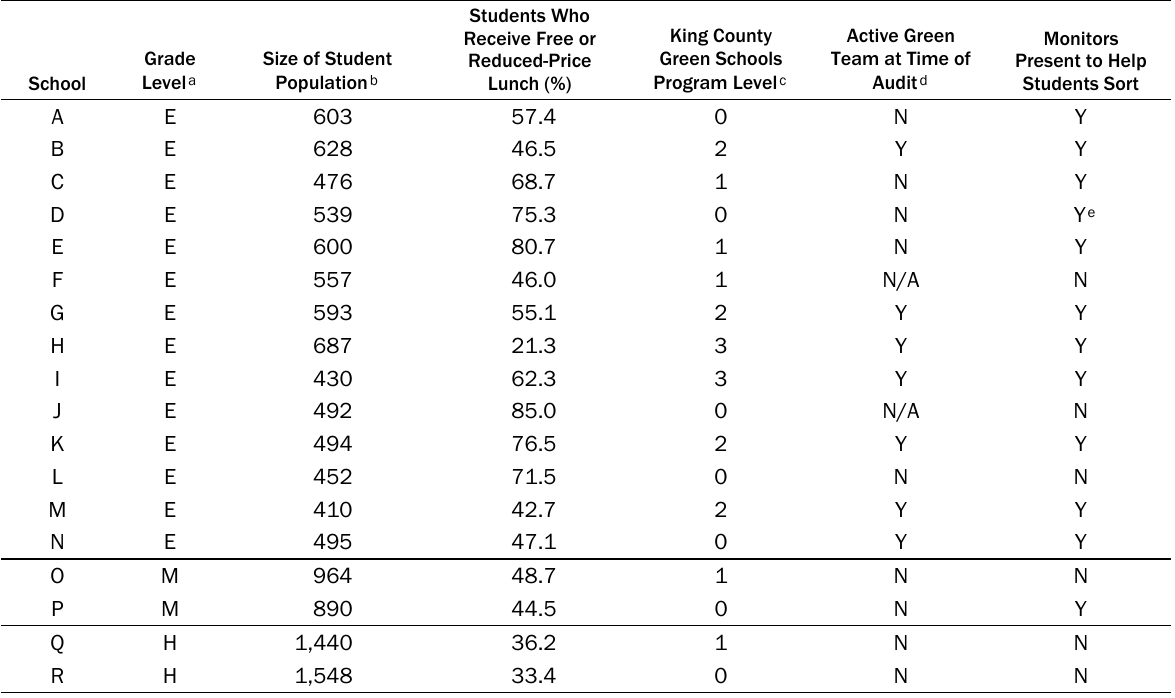
Table 1. Characteristic Data for All Schools